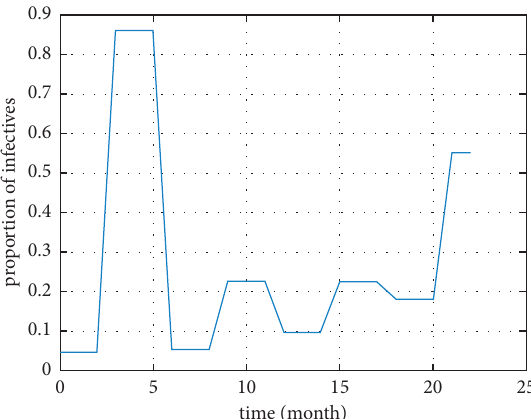
Figure 15: Te proportion of infective curves from smoothing by bin means data and the model.